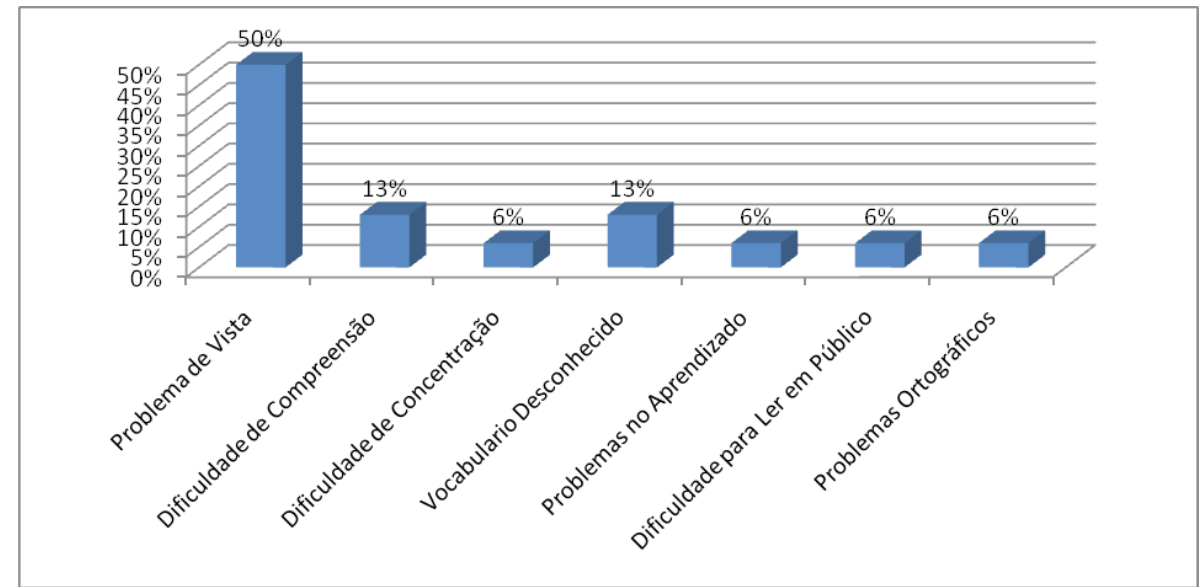
Figura 4. Dificuldades de leitura